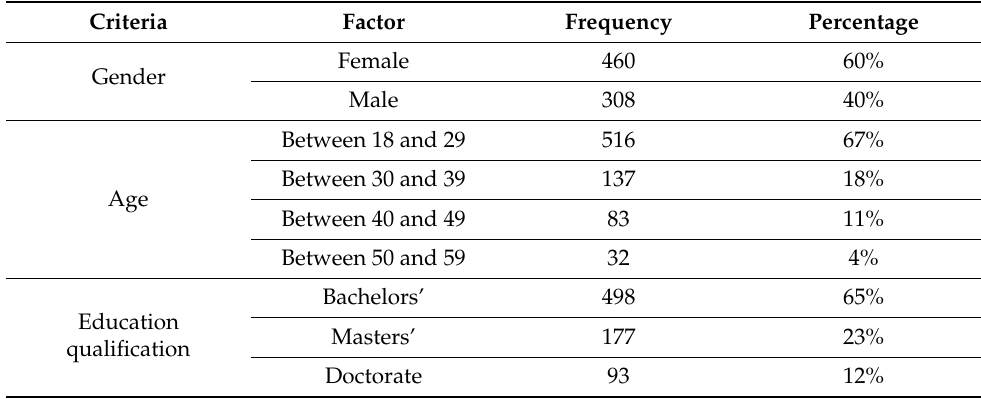
Table 4. Demographic data of the respondents. Criteria